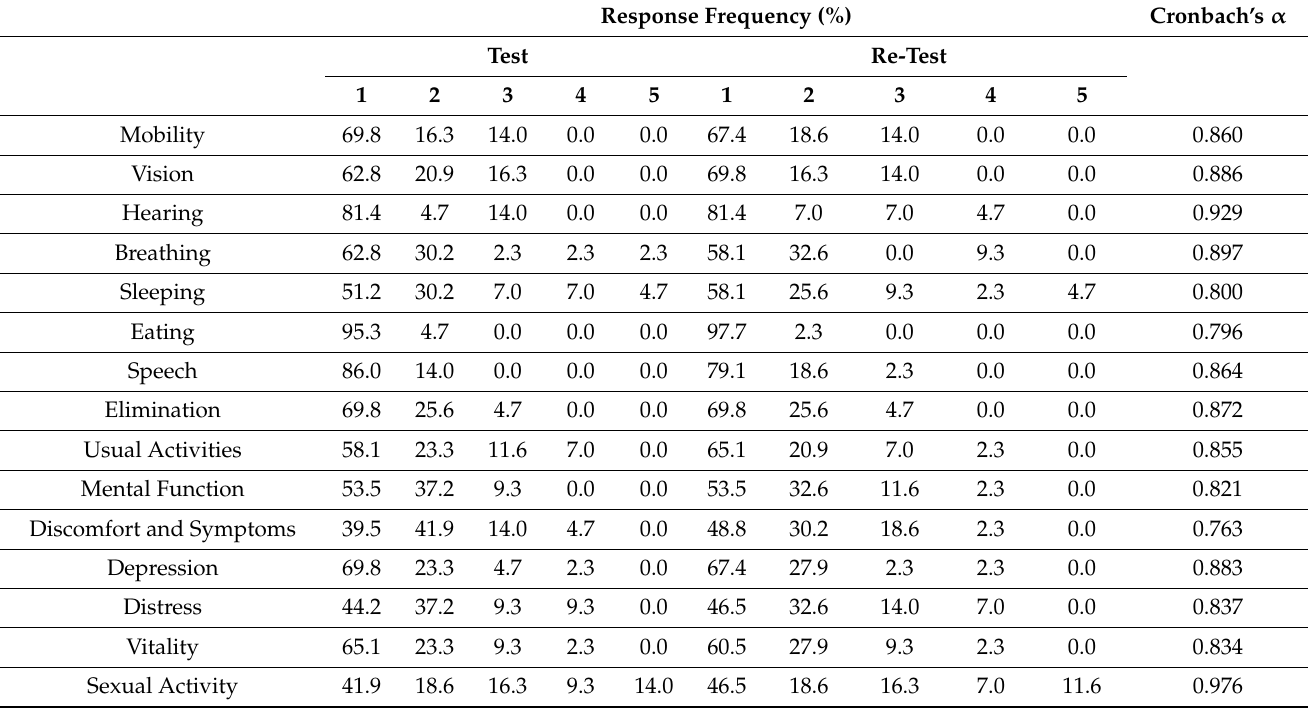
Table 3. Statistical description and internal consistency of the